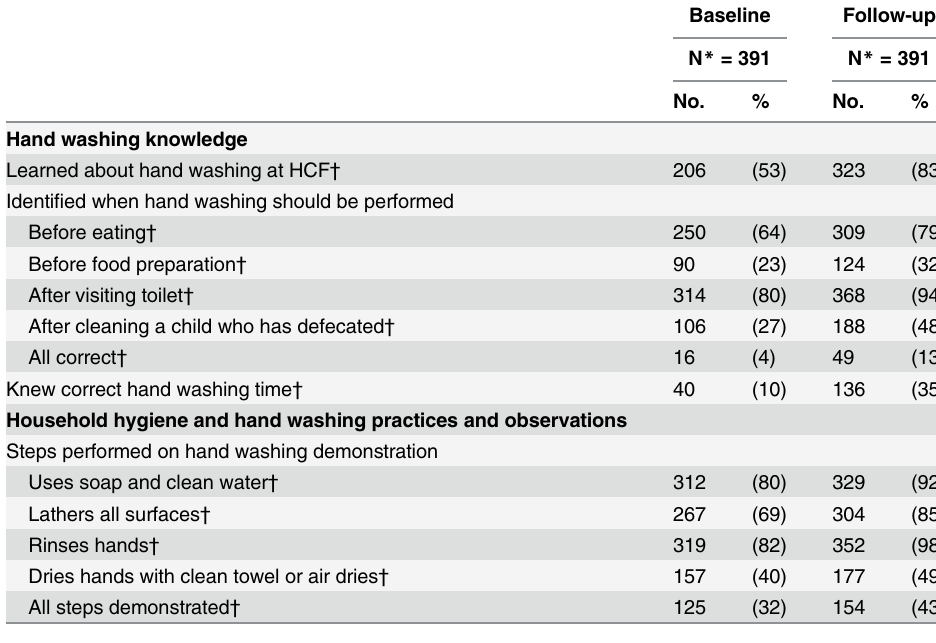
Table 4. Household knowledge, attitudes and practices regarding hand hygiene at baseline and fol- low-up, Nyanza and Western Provinces, Kenya, 2011 and 2012.